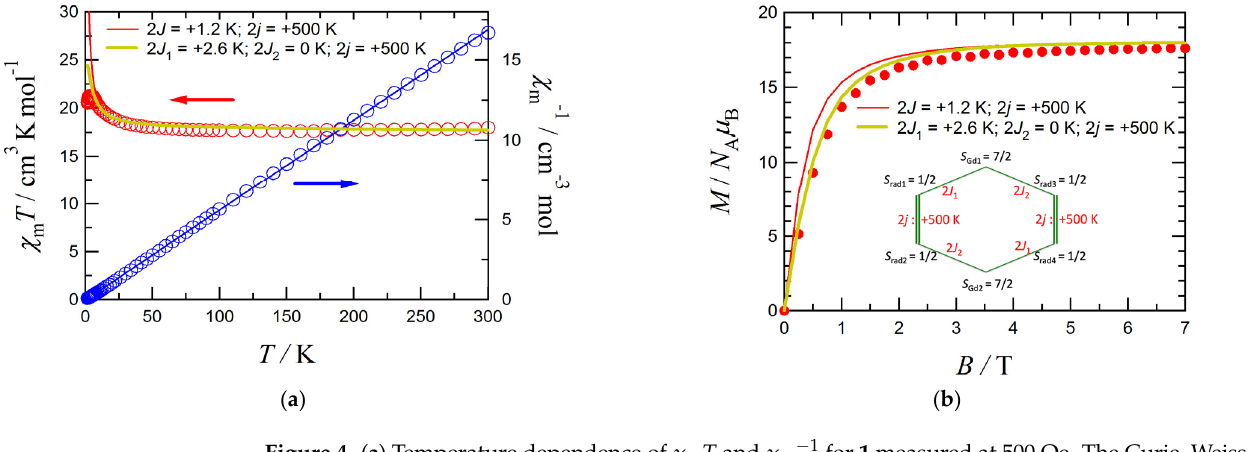
Figure 4. ( a ) Temperature dependence of χ m T and χ m − 1 for 1 measured at 500 Oe. The Curie–Weiss best fit is drawn as a solid line on the χ m − 1 data. Solid lines on the χ m T data stand for the simulation curves based on a model drawn in the inset of ( b ). The first model involves a condition J = J 1 = J 2 . ( b ) M-H curve for 1 measured at 1.8 K. Solid lines stand for the simulation curves based on the same parameters as those of the solid lines in ( a ). The inset of ( b ) shows a schematic spin–spin coupling